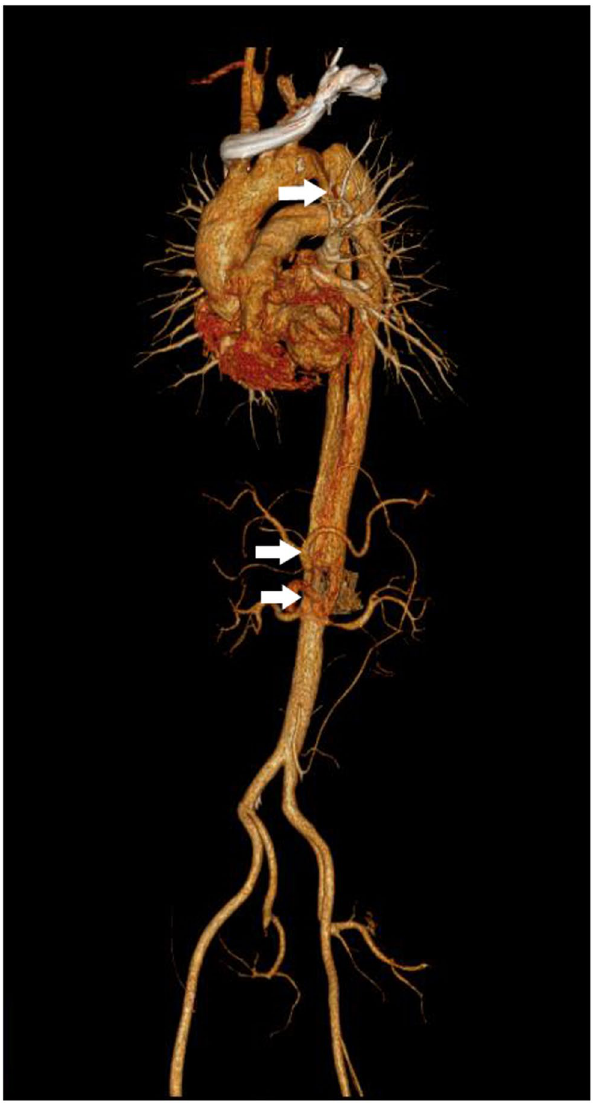
Figure 2. Thoracic aortic dissection aneurysm (Stanford B type) with a type II arch. A proximal lesion was located 30 mm from the site of left subclavian artery. The white arrows indicate